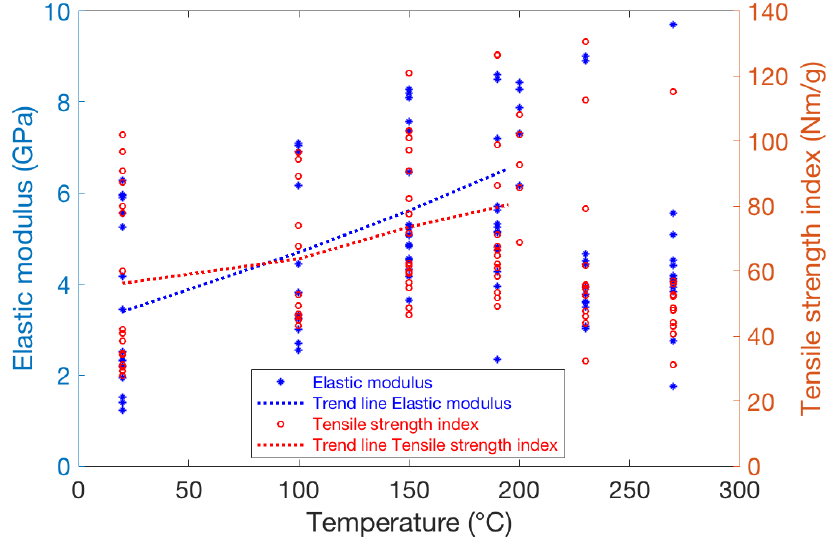
Figure 10. Elastic modulus and dry tensile strength index for a wide data set of sheets with uniform fibre orientation and different furnishes. One should notice that samples above 200 °C have been pressed using the steel-belt press, and those in the range of 20 − 200 °C have been pressed with cylinder press. The dashed trend lines describe the average behaviour for varied pressing tempera- tures.